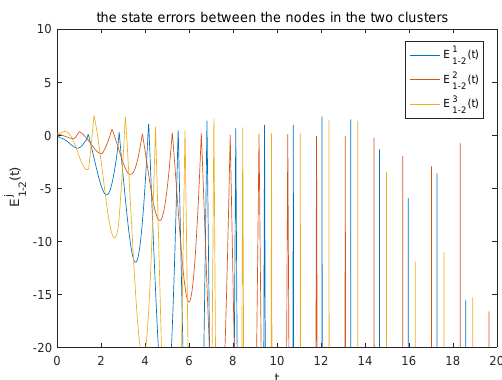
( t ) , ( i = 1,2, j = 1,2,3 ) . i